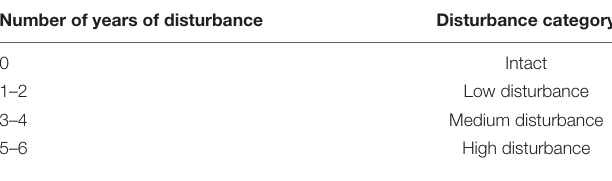
TABLE 1 | Disturbance index